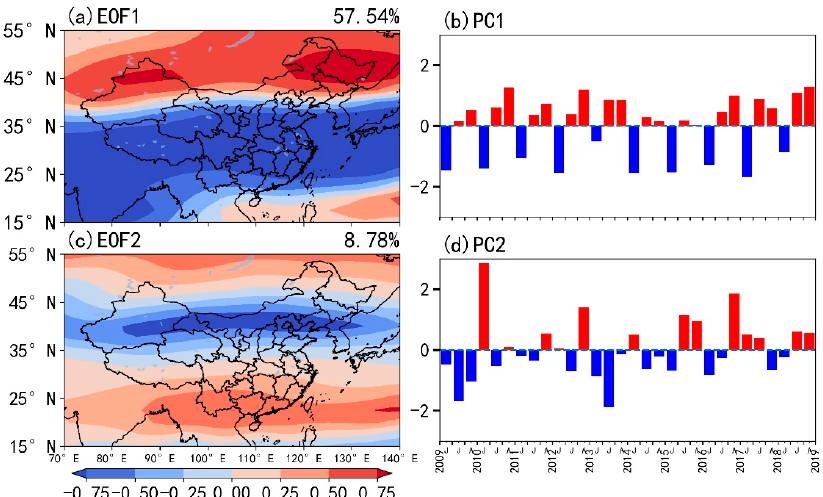
Figure 2. Spatial distributions ( a , c ) and the time coefficients ( b , d ) of the EOF1 and EOF2 of the 200 hPa zonal wind in summer from 2009 to 2018. 200 hPa zonal wind in summer from 2009 to